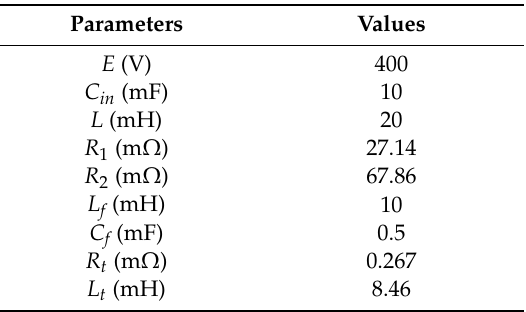
Table 1. Used circuit parameters.